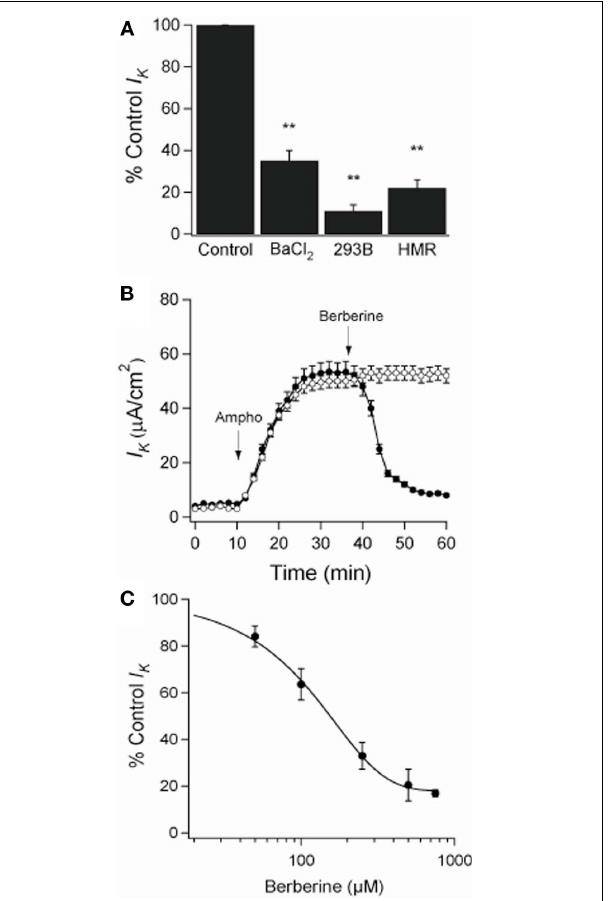
FIGURE 2 | Effect ofberberine on basolateral K + current (I K ) across apically permeabilizedT84 cell monolayers. (A) Effect of KCNQ1 channel